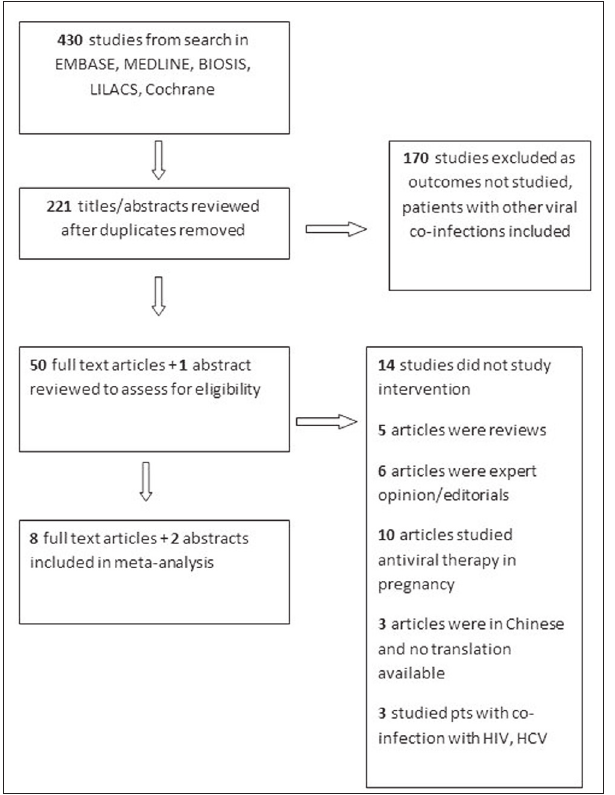
Figure 1) Flow diagram of the study search and selection process. HCV Hepatitis C virus; pts Patients